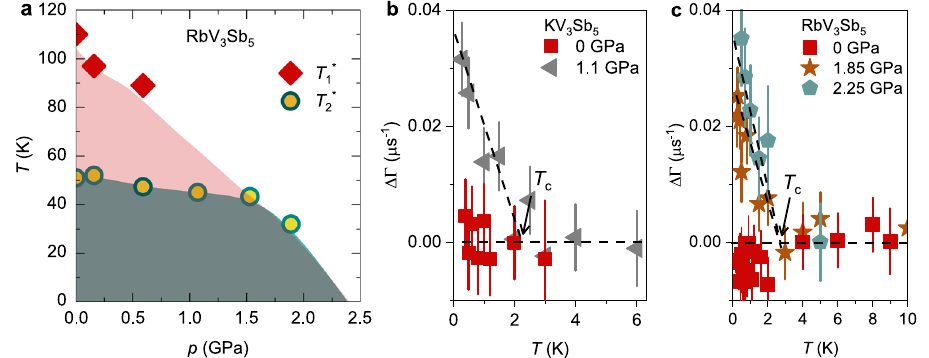
temperature range across T c , measured at ambient pressure and above the critical pressure at which T c is maximum. The error bars represent the standard deviation of the fi t parameters.